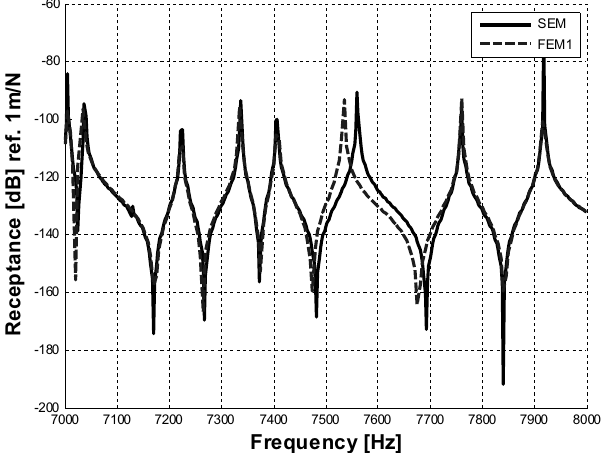
Fig. 4. FRFs obtained with SEM and FEM1 models for a frequency range 7–8 kHz.